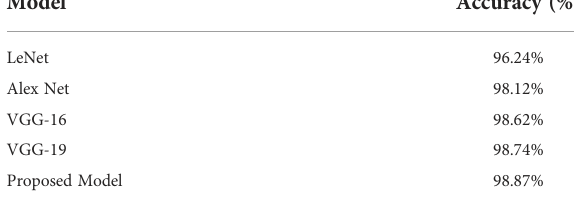
TABLE 7 Accuracy Comparison with existing models.